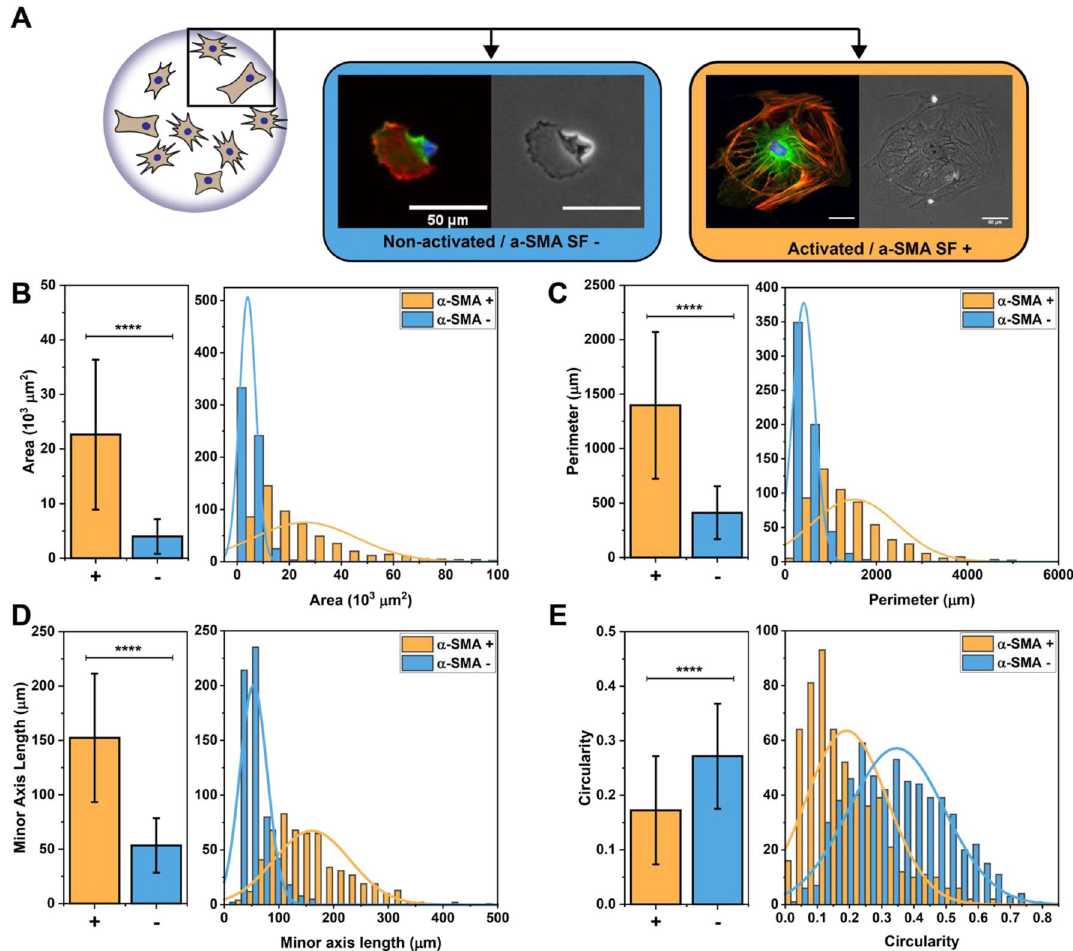
Figure 1. ( A ) Representative 3 channel fluorescent (Red:F-actin, Green:α-SMA, Blue:DAPI) and phase contrast images of myofibroblasts and fibroblasts (scale bar = 50 μm) ( B – E ) Bar plots and histograms showing the averages and distribution of four cell size and shape features: area, perimeter, minor axis length, and circularity, respectively. All of these features were significantly different between the two cell phenotypes. N = 566 activated cells and 604 non-activated cells, error bars = standard deviation, **** p < 0.0001.